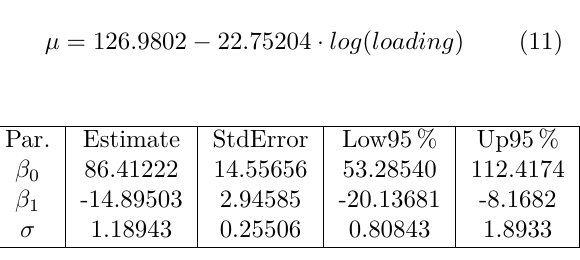
Table 5. Mean estimations for Material#2.